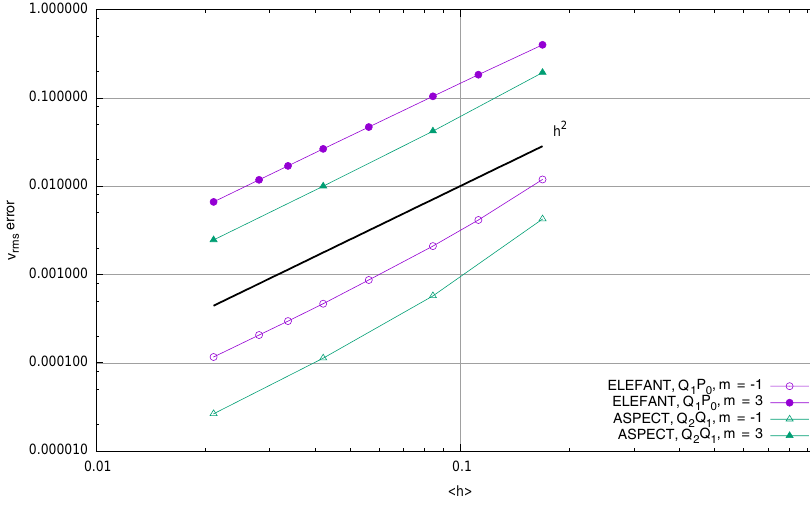
Figure 3. Root mean square velocity as a function of the average element size for both